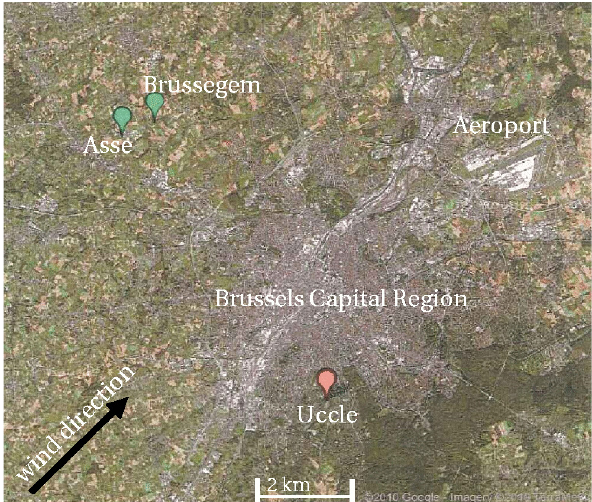
Figure 1. Study area of the Brussels Capital Region. The national recording station of the Royal Meteorological Institute of Belgium (Uccle, urban station) is marked with a red bulb, and rural stations (Asse and Brussegem) with a green bulb. The black arrow presents the direction of the prevailing wind direction in the